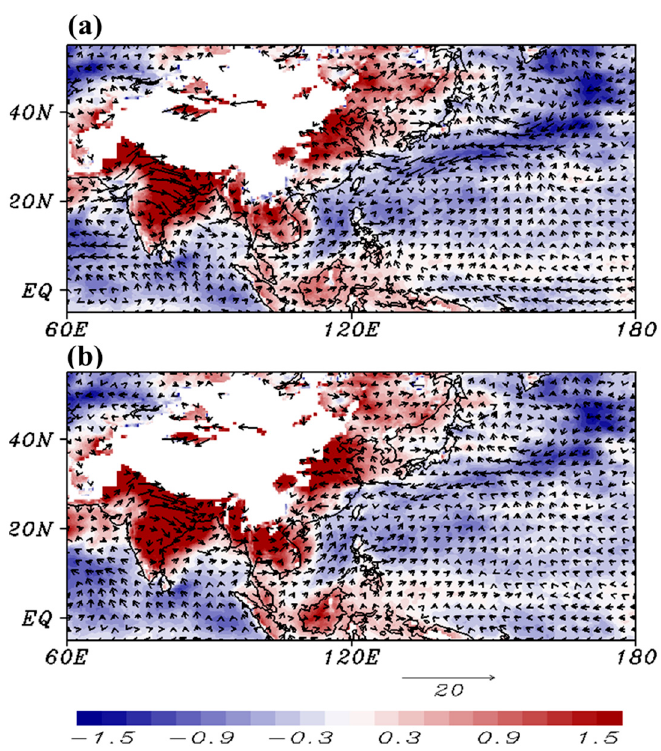
Figure 6. Biases of 900 hPa temperature (K) averaged over 96~120 h forecast based on 32 daily cases